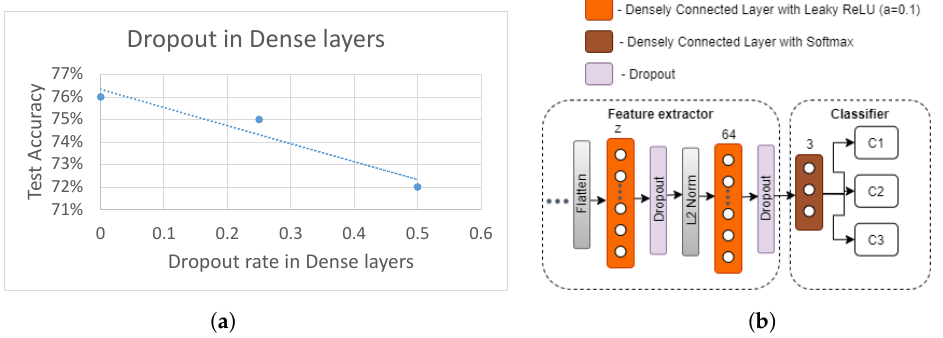
Figure 15. Effect of dropout regularization on test accuracy. ( a ) Dropout regularization results. ( b ) Classifier module with dropout regularization.